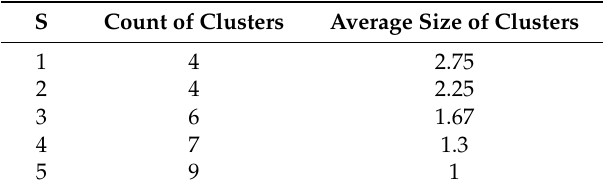
Table 6. Effect of S on the count and the average size of clusters.